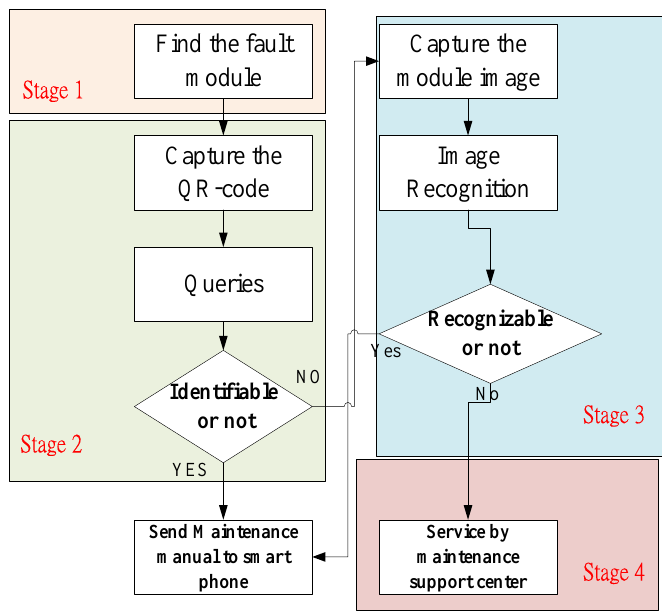
Figure 2. The LRARF process.